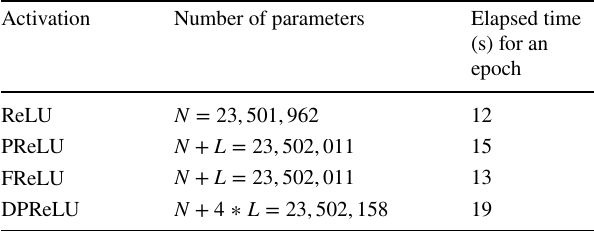
Table 8 Number of parameters and elapsed time for each activation function, where N is the number of parameters of the model using vanilla ReLU, and L is the number of activation layers in the model